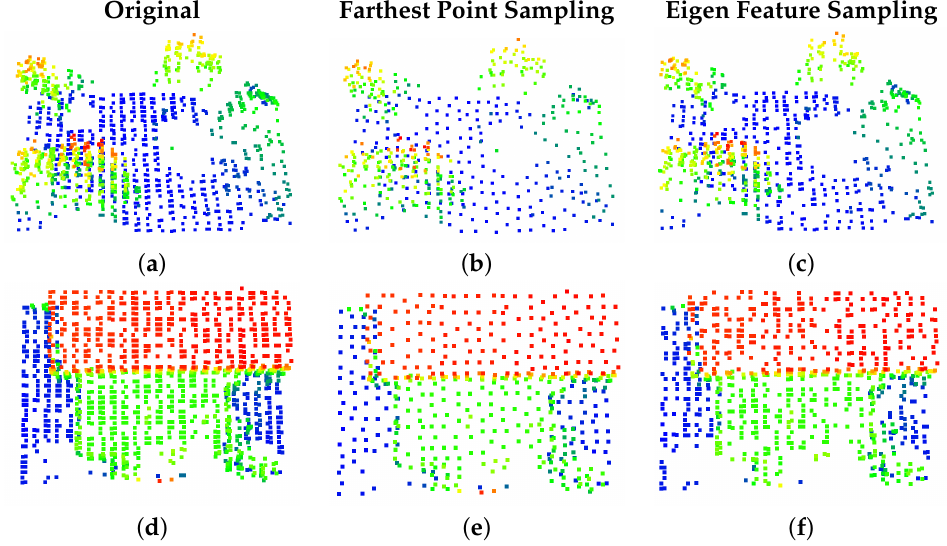
Figure 7. Visual comparison of farthest point sampling and our proposed Eigen feature sampling. Each point cloud is colored by height. The original input point cloud is shown in the right-hand column at the actual resolution of 2048 points. The center column shows downsampling to 1024 points using farthest point sampling. The right-hand column shows our Eigen feature sampling, also at